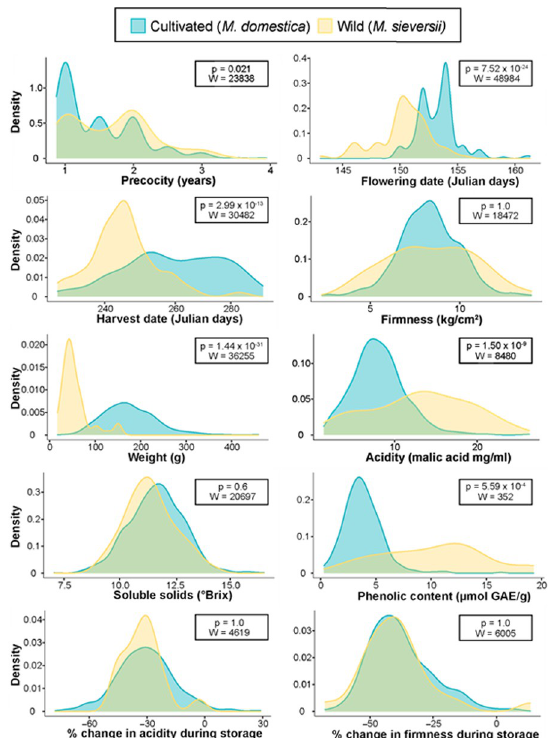
Fig 2. Overlapping density plots of 10 phenotypes comparing values from wild and cultivated apples. The phenotype associated with each plot is shown along the X axis. The W and Bonferroni-corrected p values report the results of performing a Wilcoxon rank sum test of the difference between the phenotypic distributions of wild and cultivated apples.